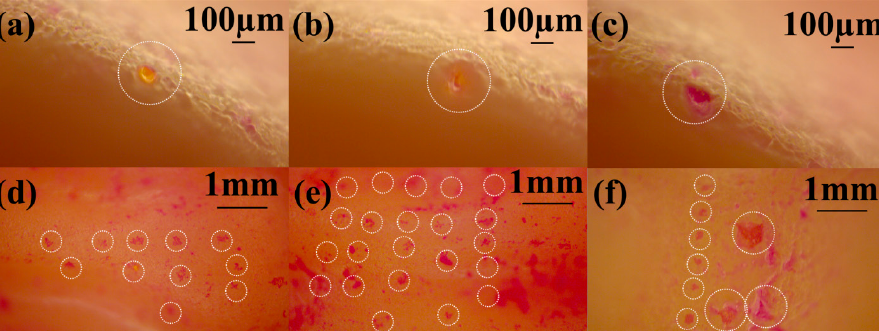
Figure 17. SEM images for the mechanical failure testing of the microneedles (MNs) with ( a ) breakage of the tip observed from forces of ~30 N and a ( b ) complete failure obtained at values of ~40 N. 3.3. Microfluidics For the microfluidic devices, the PET/adhesive lamination seals the microfluidic channel from the bottom making it possible to define channel dimensions 150 μm wide and 100 μm deep. It is important to point out here that an opening of 150 μm was successfully defined with the 3D printer as the channel was only 100 μm deep, which corresponds to only 4 printed layers. Other factors such as microscopic contaminants of cured resin as discussed (3D Print Optimization section) additionally limit the accuracy of the final print. Figure 18a,b depict optical micrographs of a monolithically printed microfluidic channel from the top and the bottom after the introduction of flow with Gentian violet and R6G. For the Y-channel (Figure 18a), it is observed that the violet and pink colors respectively of the reagents provides an evidence of mixing, although once the reagents are mixed, the color of the gentian violet begins to dominate the resulting fluid. The functioning of a multi-layer printed microfluidic channel is depicted in Figure 18b. It is observed that the liquid makes an easy transition from the top to the bottom microfluidic layers through the microfluidic via of 400 μm. An optical micrograph of the microfluidic via and the fluid flowing through the via from the top to the bottom layers of the device are additionally shown in the inset. To analyze the behavior of the printed microchannels, fluidic resistance in the Y-channel was obtained by varying the concentration of Dulbecco’s PBS buffer (Figure 19a). A linear fit of the fluidic resistance with concentration is obtained for similar volumes of the injected solution ( n = 3) in the microfluidic device depicting an ohmic nature as expected [57]. To further study the micromixing capability of the Y-channel in the presence of cell like material (~1.1 μm PS beads), optical counting of the beads was performed for different concentrations of the PS beads in the junction of the Y-channel and compared to a polystyrene petri